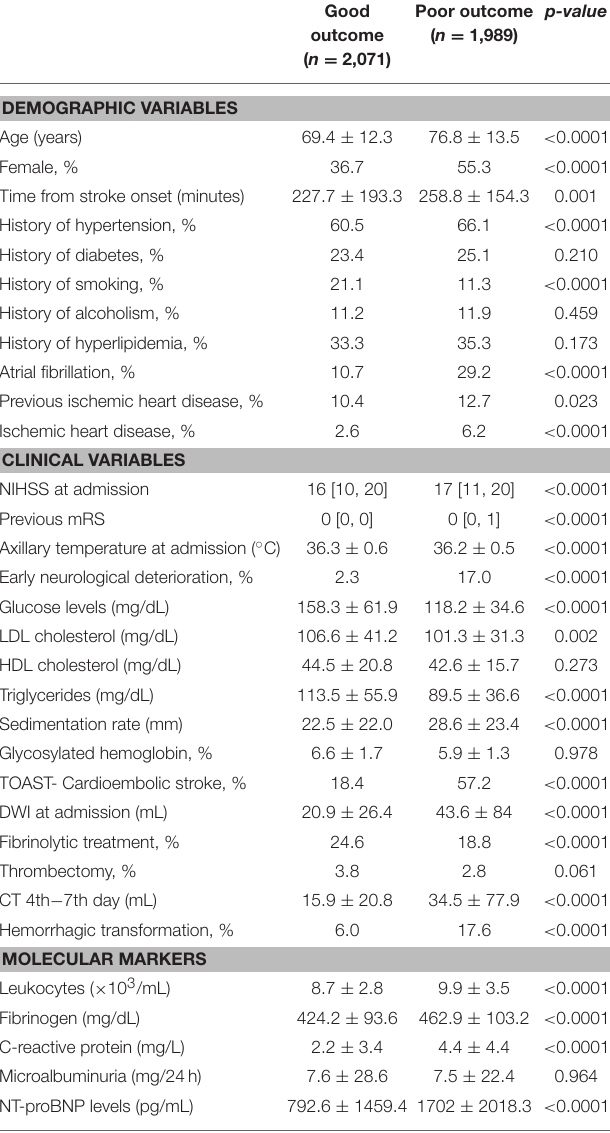
TABLE 4 | Multivariate analysis: Adjusted OR of poor outcome at 3-months for baseline associated variables in the univariate analysis in IS patients. Independent